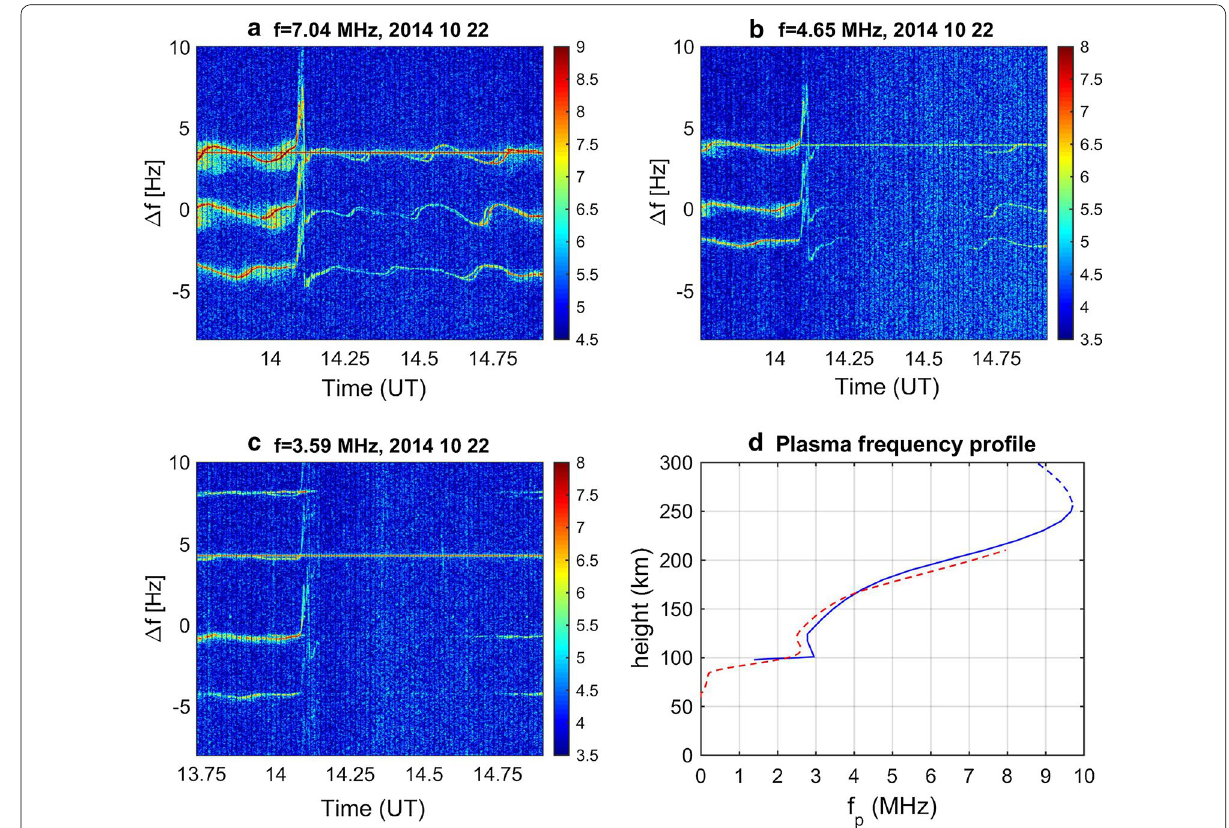
Fig. 3 Spectrograms recorded by the CDSS in the Czech Republic on 22 October 2014 from 13:45 to 14:55 at a 7.04 MHz, b 4.65 MHz, c 3.59 MHz, d Plasma frequency as a function of height obtained from ionospheric sounder (blue) and from IRI‑16 model (red) at 14:00